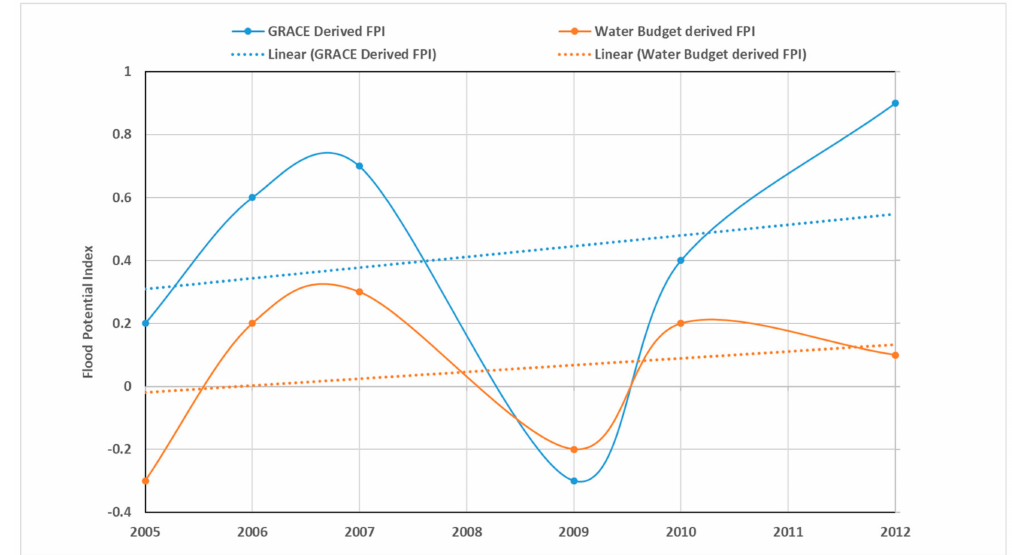
Figure 13. Trend plots for GRACE-derived and water budget-derived FPI s.